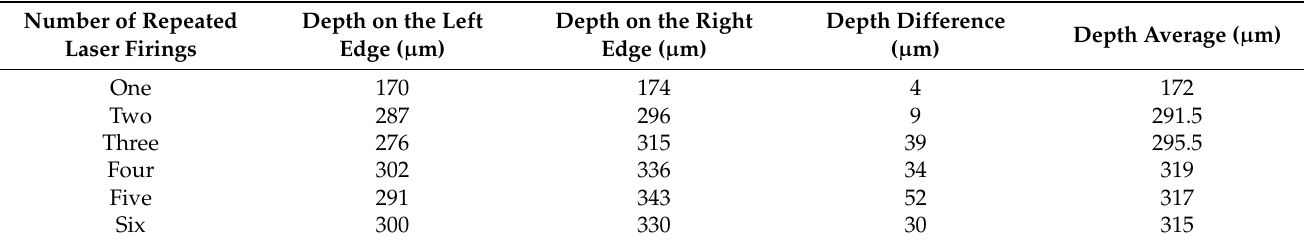
Table 4. The measured depth values after different numbers of repeated laser firings with the 5.5w_30k_300_re50 (15- µ m metal surface) recipe.